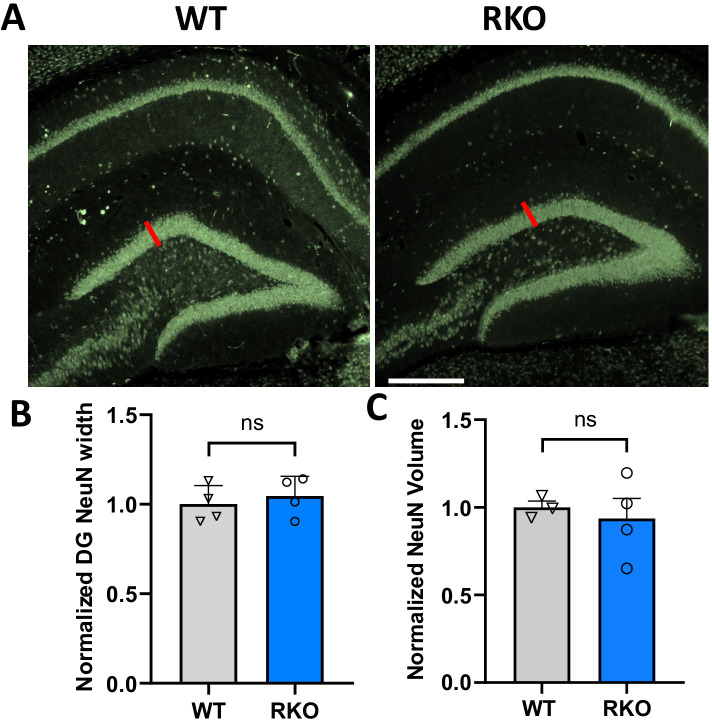
No change in dentate gyrus neuronal layer volume or width in RKO mice.(A) Representative image of NeuN immunoreactivity in the dentate gyrus of a 6mo WT and RKO mice. (B) Average thickness of NeuN+ neuronal nuclei layer in WT and RKO mice. Red line in A indicates how measurements were taken; six measurements/section along the DG were averaged, N = 4 mice/genotype. (C) Volume of DG NeuN signal was quantified in 10 µm section z-stacks from N = 4 mice/genotype. Normalized NeuN volumes are shown. In B and C, each point represents a single mouse. Ns = not significant. Scale bar = 100 µm.